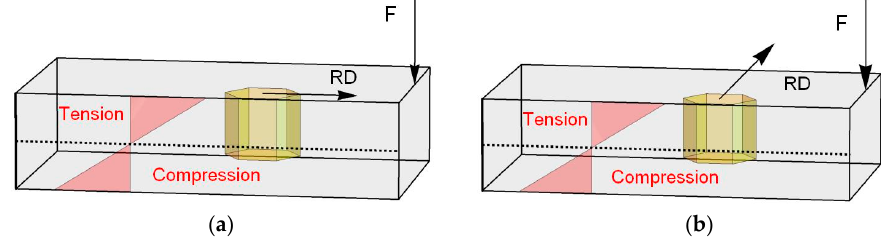
Figure 14. Schematic illustration of the sample geometry with respect to the hexagonal cell: ( a ) L orientation; ( b ) T orientation.